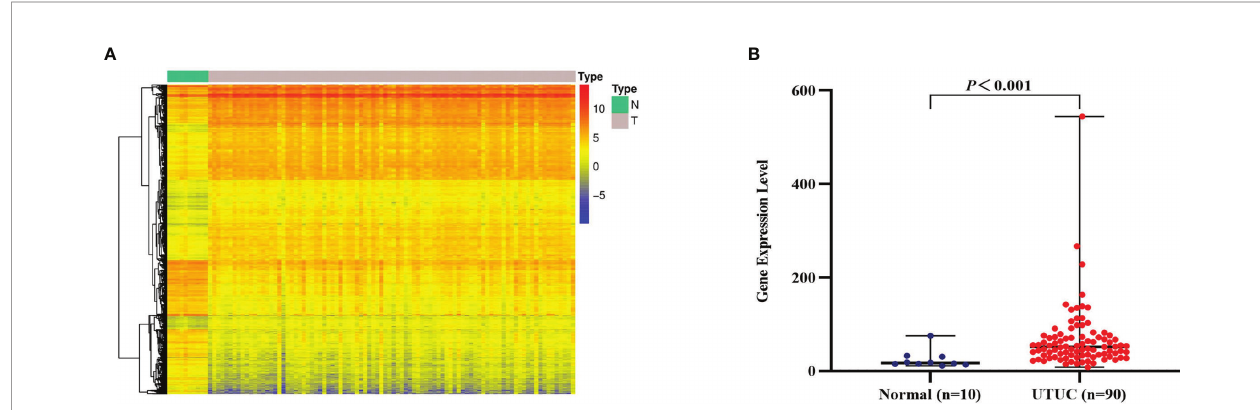
FIGURE 1 | Identi fi cation and analysis of differentially expressed genes (DEGs) and CD47 mRNA expression. (A) Hierarchical clustering of DEGs, with rows representing genes and columns representing samples. For a gene, red represents a higher expression level, blue represents a lower expression level, and yellow represents the median expression level for all samples. (B) CD47 mRNA expression levels in the upper urinary tract urothelial carcinoma (UTUC) (n = 90) group and normal group (n = 10) (|log2FC| = 1.43, P < 0.001), and P -values were determined using Wilcoxon rank-sum